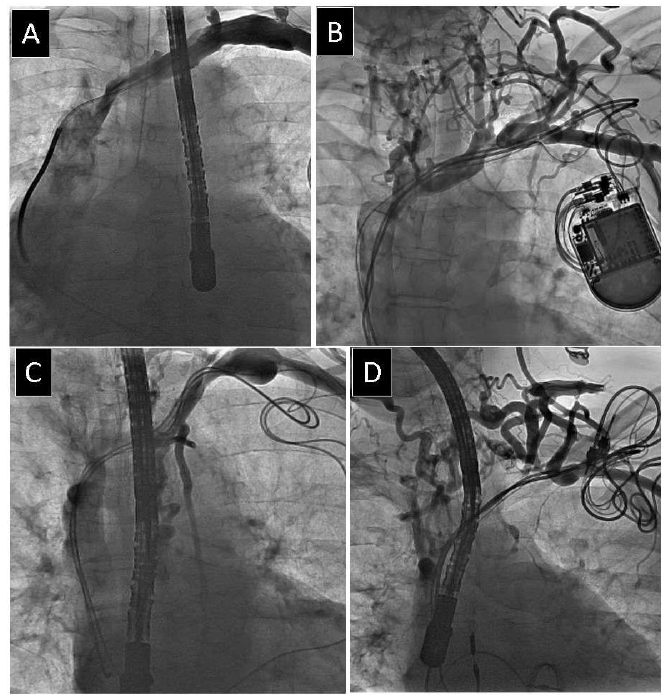
Figure 3. Different degree of obstruction of anonymous vein. ( A ) Mild narrowing of anonymous vein. ( B ) Moderate narrowing of anonymous vein. ( C ) Severe narrowing of anonymous vein. ( D ) Complete occlusion of anonymous vein.